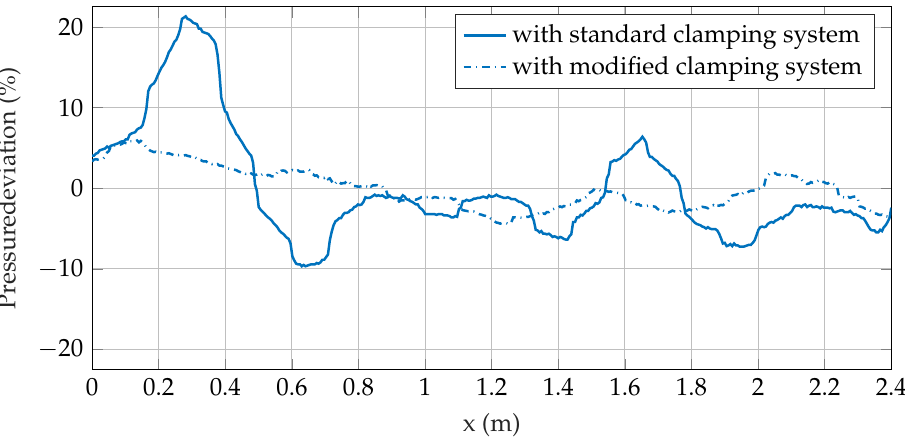
Figure 9. Reduction in the pressure deviation during the cut-through modification of the clamping